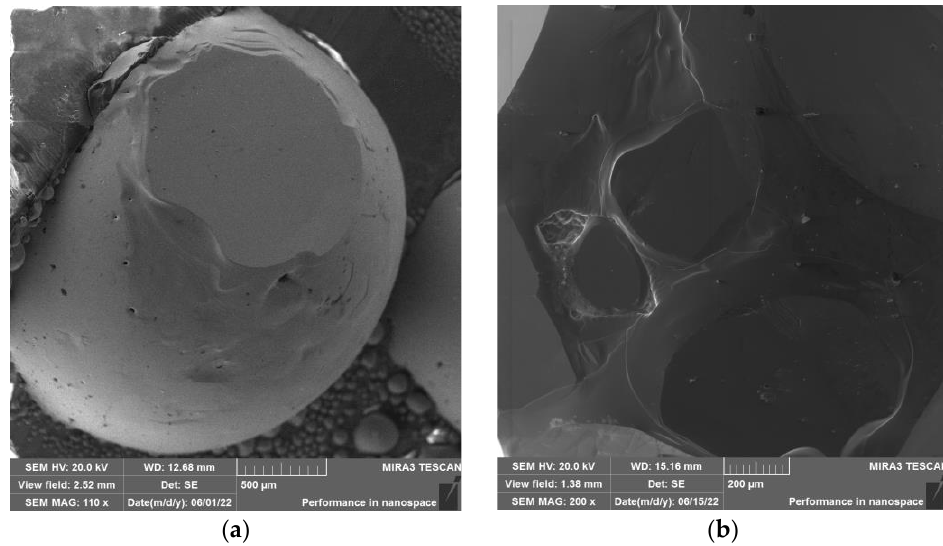
Figure 10. Morphology of the obtained zinc product (evaporation process under the temperature of 700 ◦ C) in the form of “drop” at ( a ) 500 µ m magnification and ( b ) 200 µ m magnification. Results of SEM analysis of the product in the form of “drop” is shown in Figure 10a,b. Spherical products of various sizes have a smooth surface.